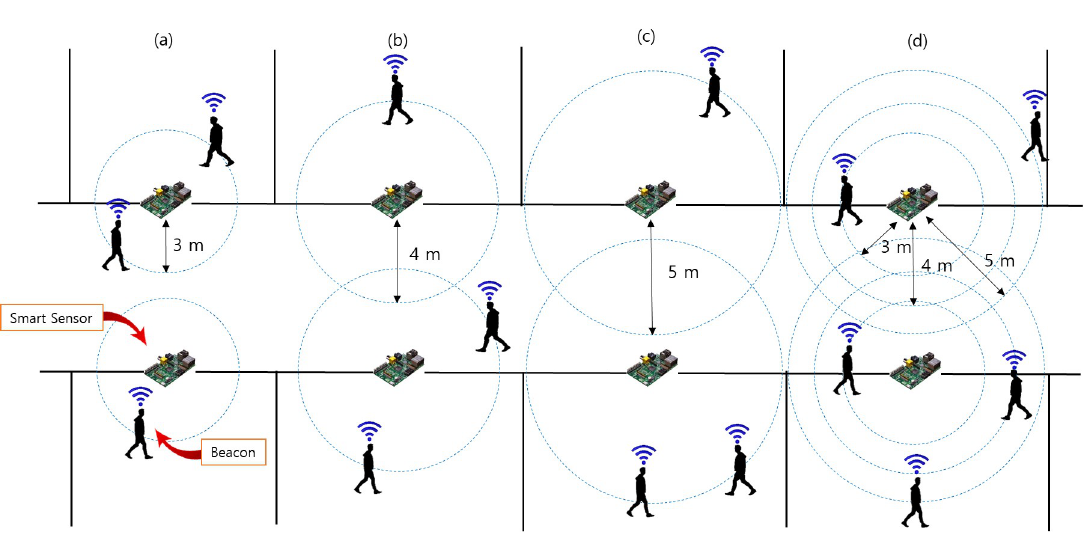
Figure 11. The experimental setting used for localization accuracy evaluation. Participant walks in